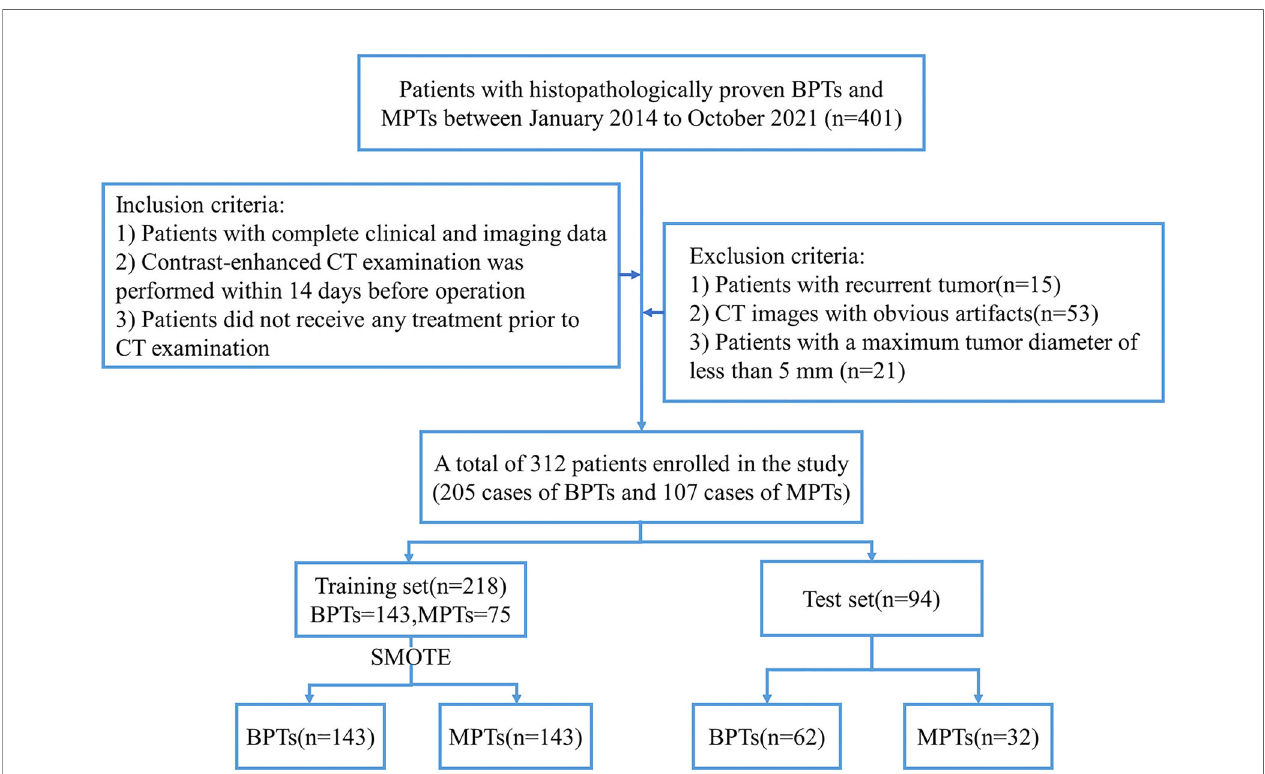
FIGURE 1 | Flowchart of patient recruitment. BPTs, benign parotid tumors; MPTs, malignant parotid tumors; SMOTE, the synthetic minority oversampling